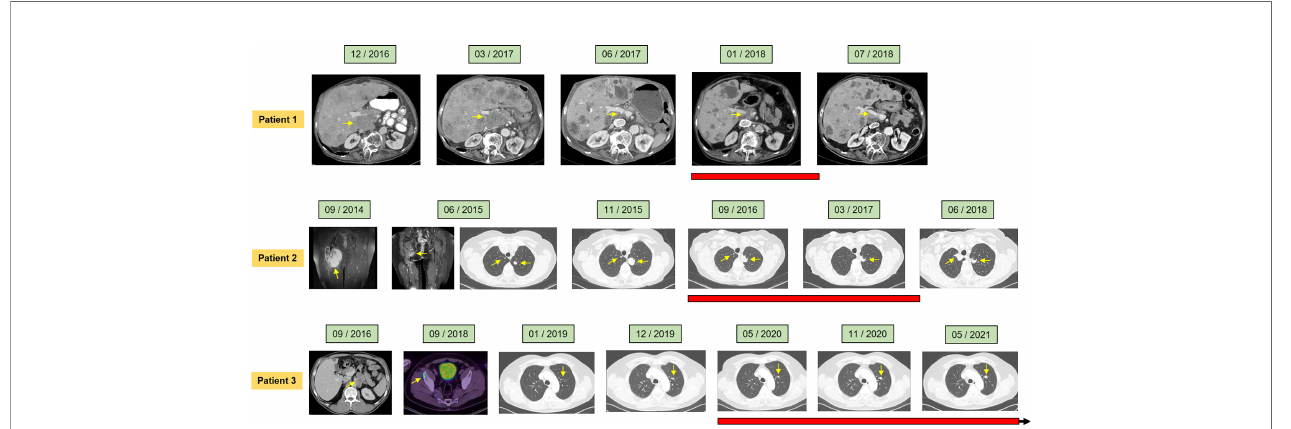
FIGURE 1 | Clinical course of the individual patients assessed by radiological imaging depicting treatment response at the indicated time points. Computed tomography (CT), magnetic resonance imaging (MRI), and positron emission tomography were utilized (PET). Red bars denote duration of Gemcitabine maintenance therapy. Arrows indicate ongoing Gemcitabine